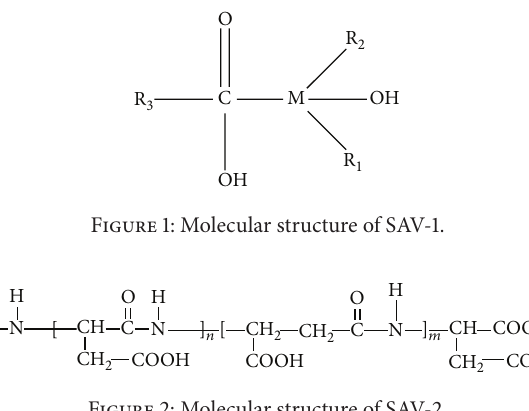
Figure 2: Molecular structure of